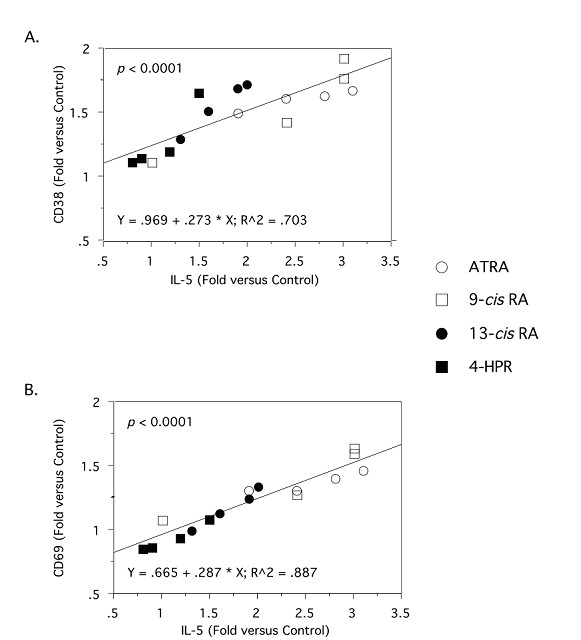
Correlation between retinoid-induced IL-5 expression and T cell-associated CD38 and CD69 expression in anti-CD3, -activated PBMC. IL-5 protein levels were quantitated by ELISA in supernatants of 48 h, anti-CD3,-activated PBMC treated with ETOH or ATRA (○), 9-cis-RA (□), 13-cis-RA (●), or 4-HPR (■). The values for the level of expression (mean channel number) of CD38 and CD69 on T cells were obtained by flow cytometry of cells from the same culture. Simple regression was performed on these values as described in Materials and Methods. Data shown is average fold change calculated from three experiments.